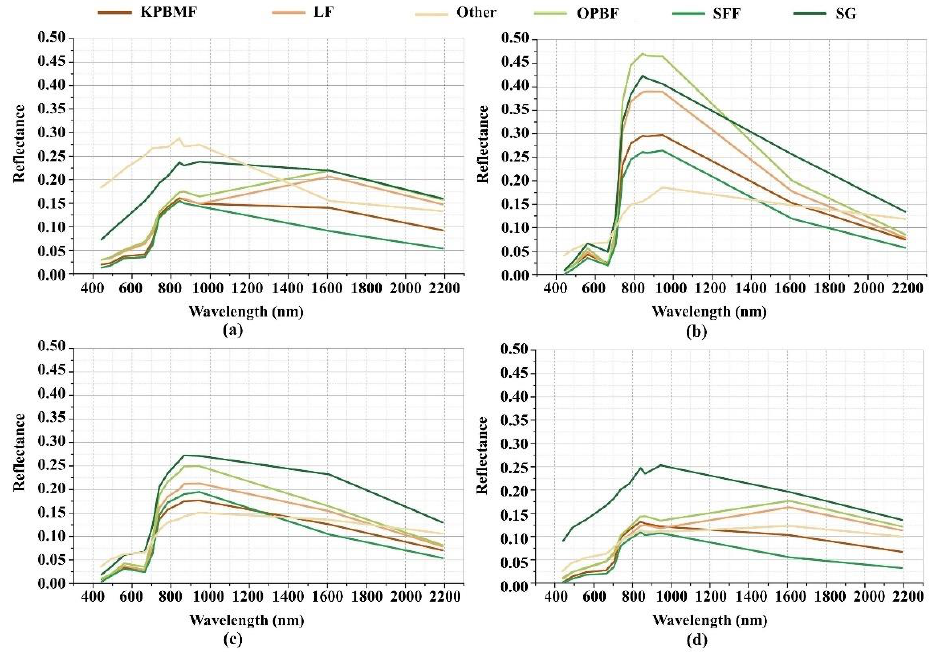
Figure 3. The mean spectral reflectance for each tree species illustrated for each image date: ( a ) 3 May 2019, ( b ) 27 June 2019, ( c ) 25 September 2019, and ( d ) 20 October 2018. The increased reflectance of shrub grassland stands on 20 October 2018 can be attributed to the presence of a small amount of snow.